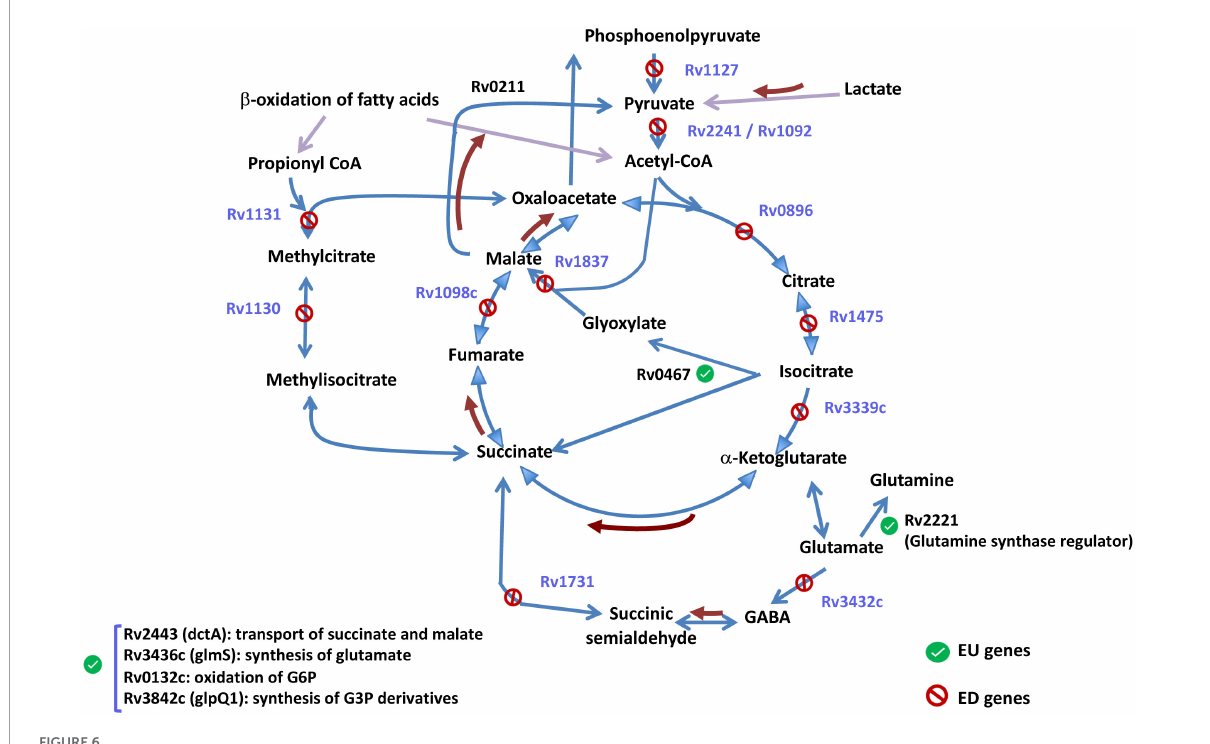
FIGURE6 Genes within the TCA cycle and related metabolic pathways. In blue, enhanced-downregulated genes (ED) (whose abrogation upon growth arrest is inhanced by iron), and in black, enhanced-upregulated genes (EU). Brown arrows identify reactions whose genes were no differentially expressed. See Supplementary Table 4 for gene expression levels.